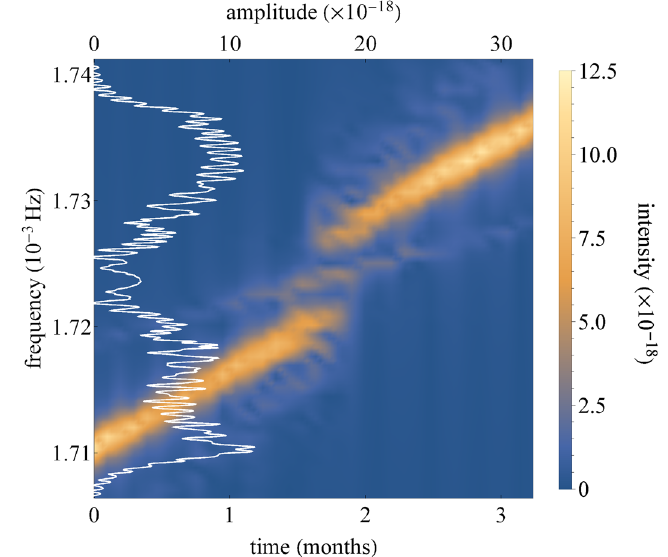
Fig. 34 Periodogram of the fundamental frequency of a gravitational waveform associated with an inspiral on a particular non-Kerr spacetime. A sudden jump in the frequency evolution appears when the inspiralling object crosses a Birkhoff island, which is associated with a valley in the amplitude of the signal ’ s frequencies (white